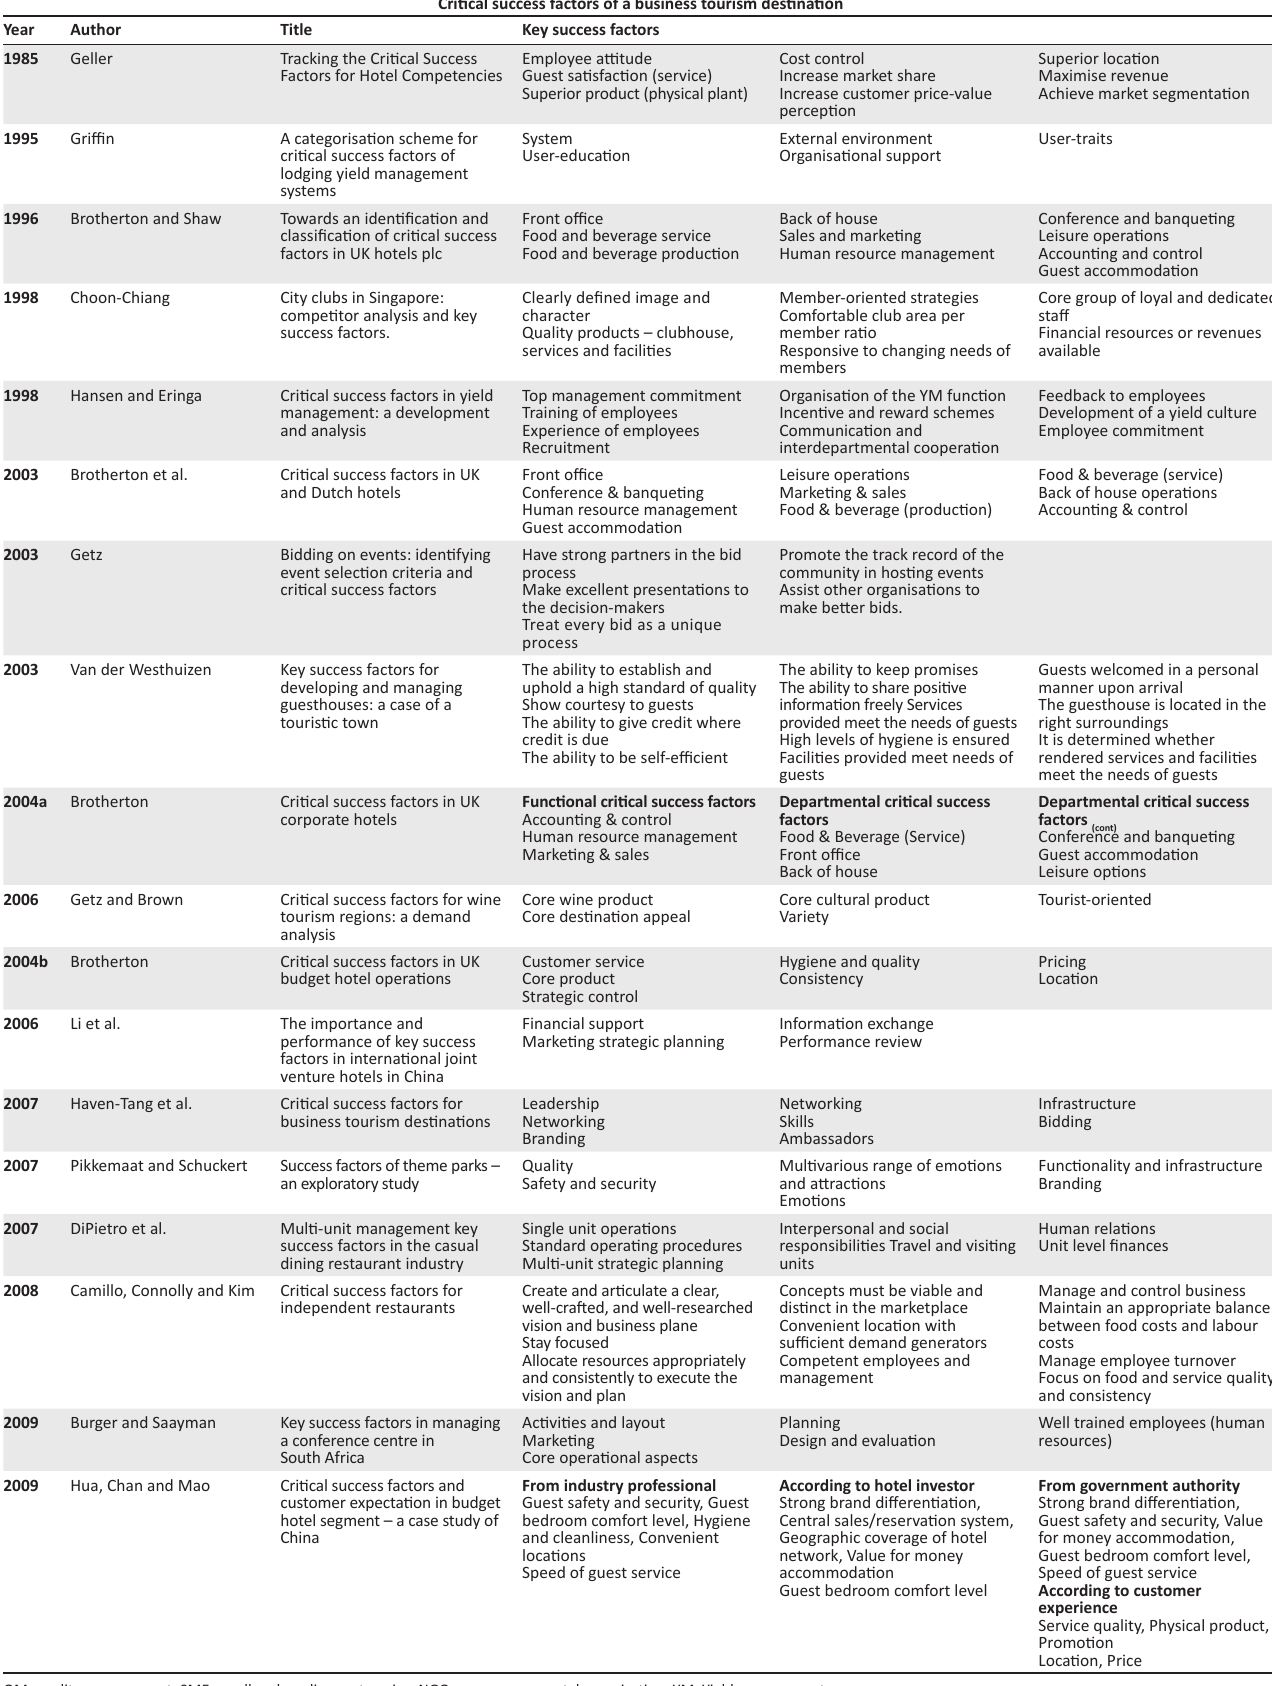
FIGURE 1: Previous published studies on critical success